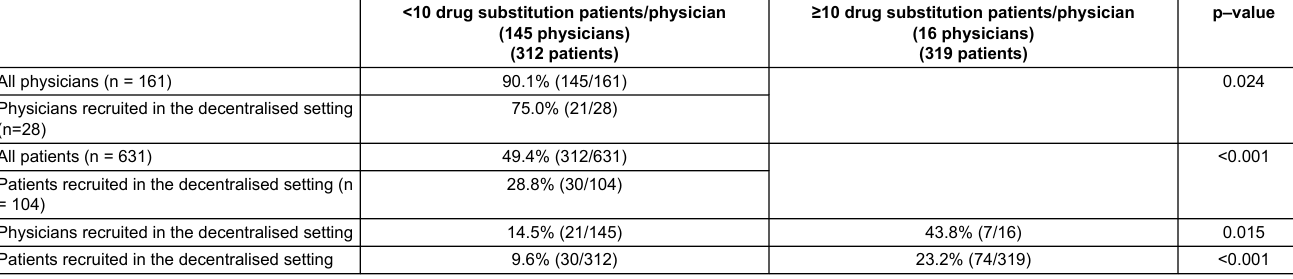
Table S2: Patients and physicians recruited in the decentralised setting.